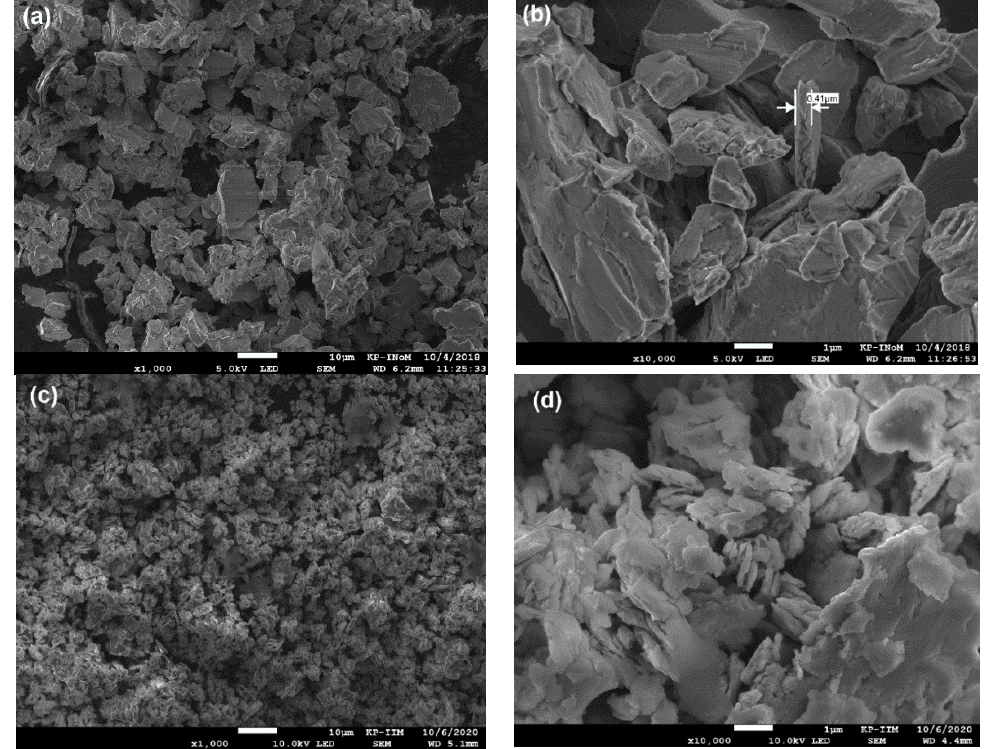
Figure 3. The microstructure of SmCo 5 /α-Fe (5%wt. of α-Fe) milled for 0.5 h ( a , b ); 10 h ( c , d ).